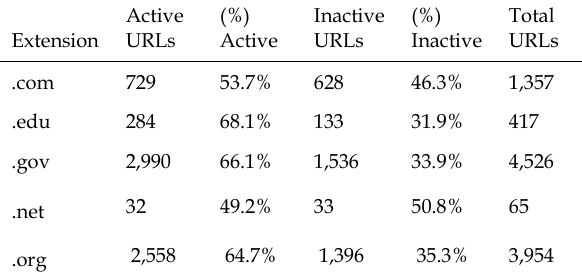
Table 4: Number and percentage of active and inactive URLs by top-level